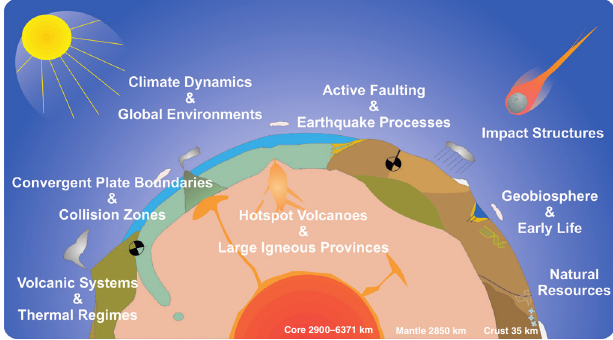
Core 2900–6371 km Mantle 2850 km Crust 35 km Figure 1. Summary of key themes of the ICDP since the year 2005